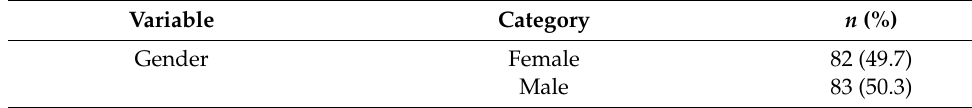
Table A3. Demographic Characteristics of the Sample, n =